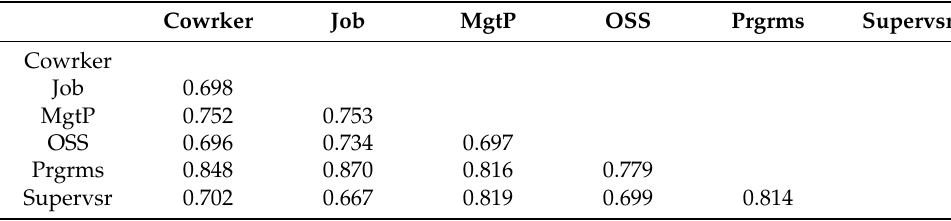
Table 5. Discriminant validity (Heterotrait–Monotrait (HTMT)).